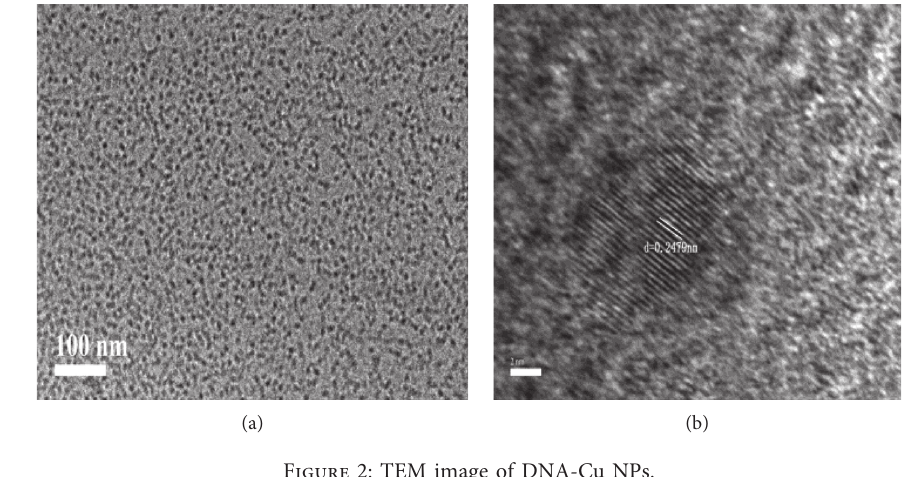
Figure 2: TEM image of DNA-Cu NPs.